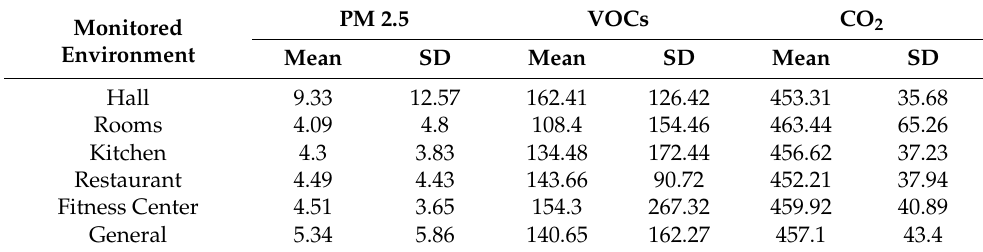
Table 3. Descriptive statistics for the different contaminants monitored, in each environment included.